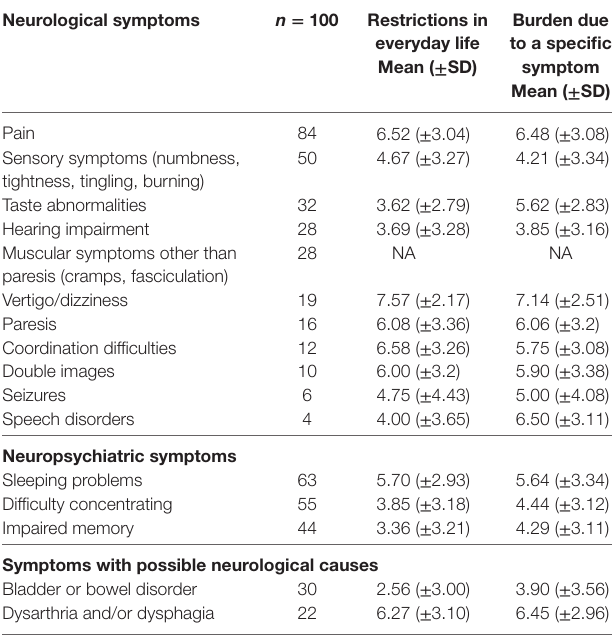
TaBle 3 | Most distressing symptoms at the time of the interview named by 100 palliative care patients. Frequency of mention